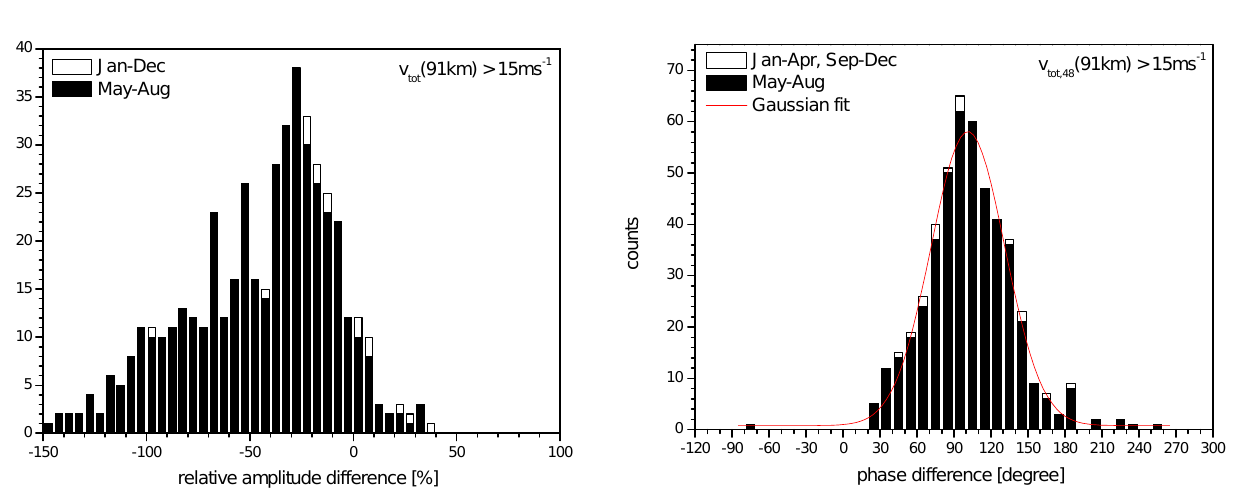
Figure 5. Histogram of the 91km (gate4) relative amplitude differ- ences (cid:49)v of zonal and meridional components for amplitudes larger than 15ms − 1 . Black bars: summer (May–August) data, 460 days considered. White bars: rest of the year (January–April, September– December) data, 17 days considered. Positive values denote larger zonal than meridional amplitudes.